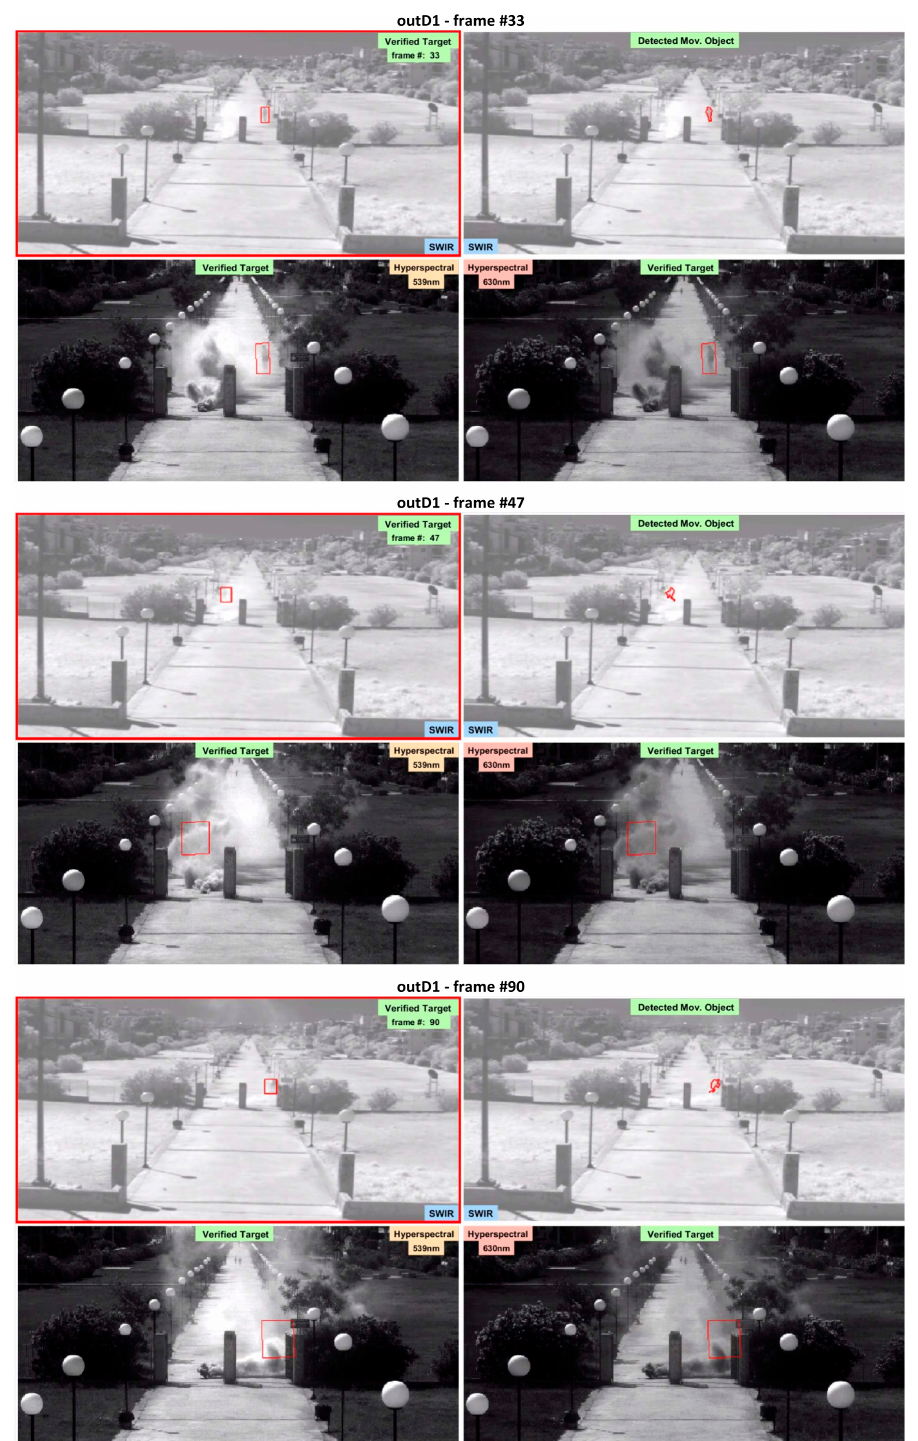
Figure 8. Detection results from the developed method (based on the BS detector) on the outD1 dataset. Frames #33, #47, and #90 are presented along with the intermediate ‘detected moving objects’ and finally ‘verified targets’ overlaid in the SWIR and hyperspectral (539 nm and 630 nm, respectively) bands.